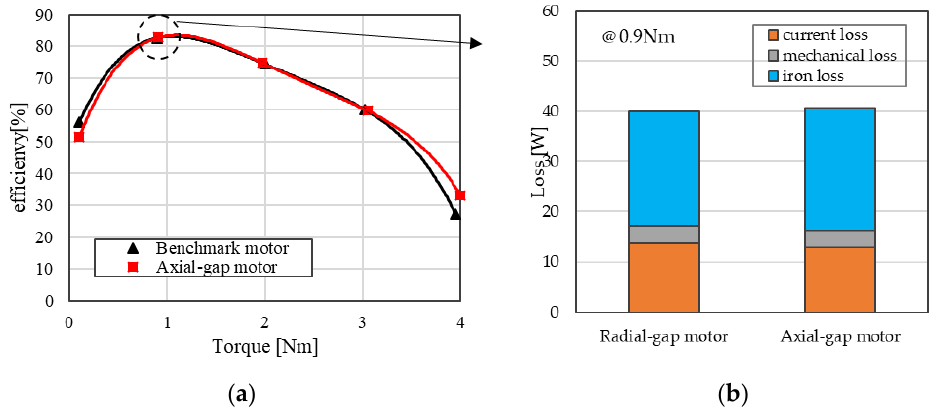
Figure 25. Efficiency with respect to torque of benchmark motor and axial-gap motor: ( a ) efficiency with respect to torque; ( b ) loss analysis at 0.9 Nm.